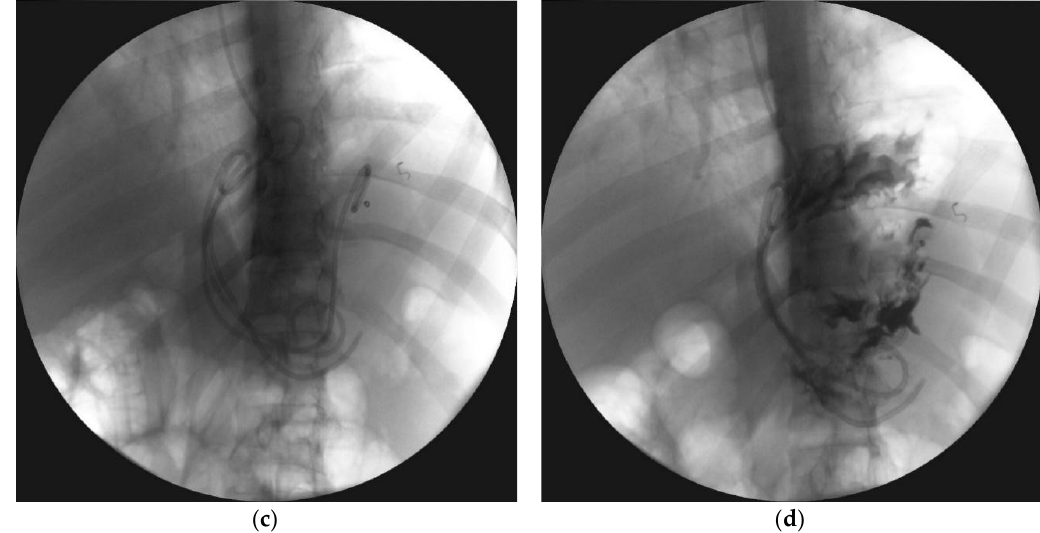
Figure 3. In the patient with symptomatic WOPN (Figure 2a,b), endoscopic transmural drainage was performed. Under EUS guidance, a cystogastrostomy was created. ( a ) The fistula was widened with a high-pressure 12-mm balloon. ( b , c ) Two stents and a nasocystic catheter were inserted into the necrotic collection. ( d ) Contrast agent was administered through the catheter and filled up the necrotic collection, which then drained freely into the stomach. EUS, endoscopic ultrasonography; WOPN, walled-off pancreatic necrosis.